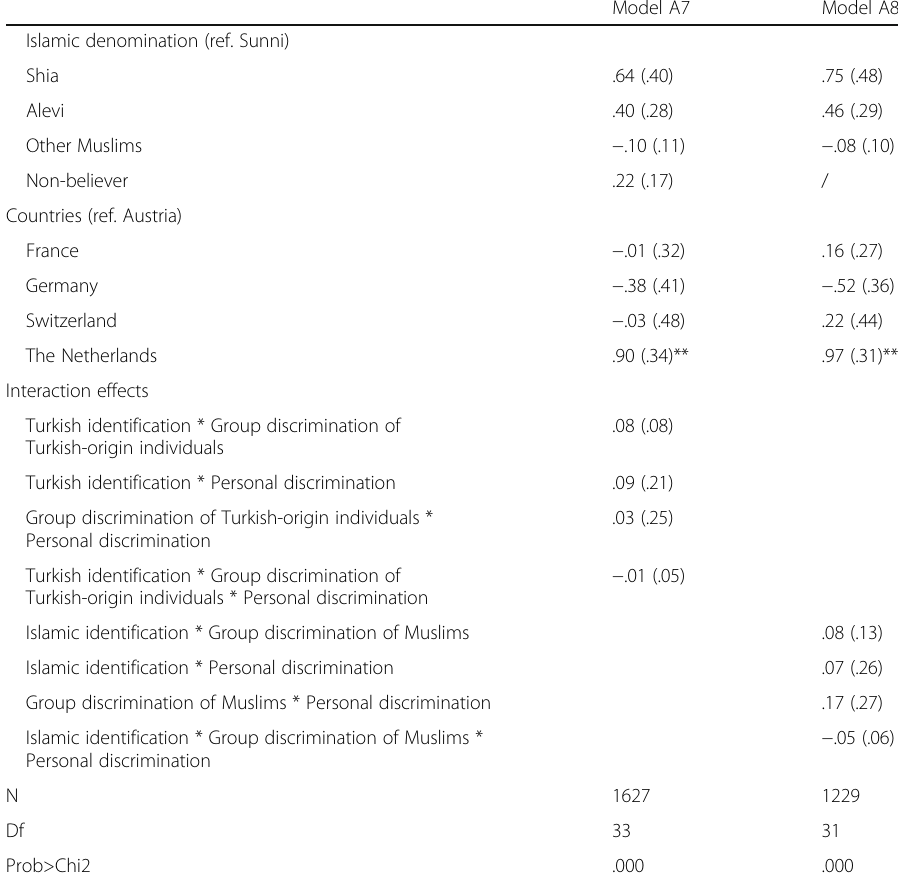
Table 12 Binary logistic regression: Interplay between social identifications, group discrimination, personal discrimination and local voting probability (Continued)